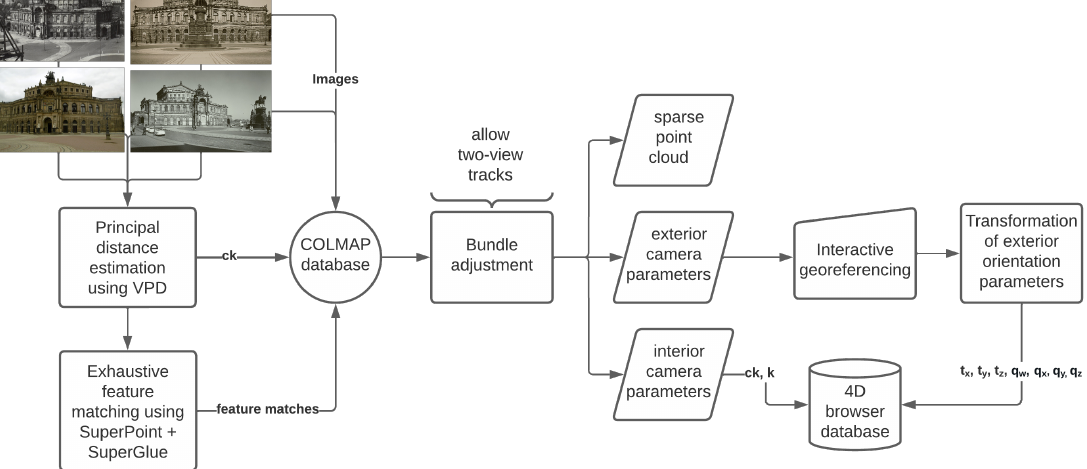
Figure 6. Workflow for the estimation of the interior and exterior camera parameters of historical